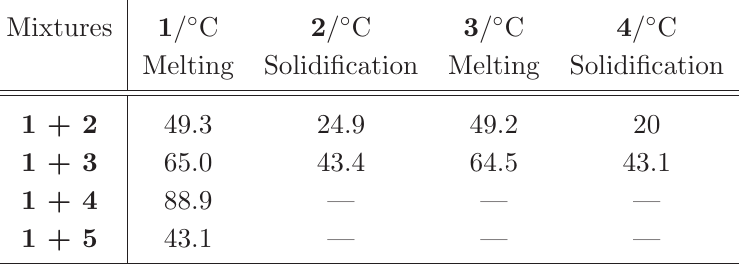
Table 7 DSC experiments (pure compounds).